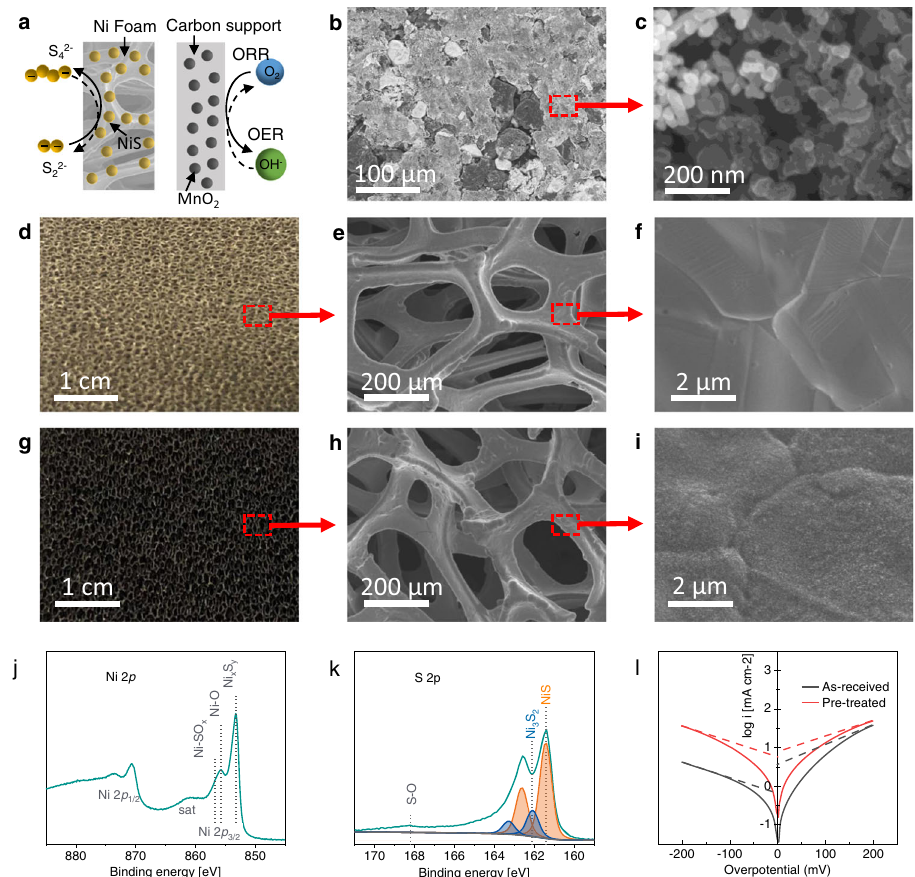
Fig. 2 Characterisation of electrodes. a Diagram of sul fi dized Ni foam electrode and MnO 2 -based air electrode for OER and ORR reactions. b , c SEM images of the commercial MnO2-based air electrode. d Photo of the as-received Ni foam. e , f SEM images of the as-received Ni foam. g Photo of the sul fi dised Ni foam. h , i SEM images of the sul fi dised Ni foam. j , k XPS core level spectra of the sul fi dised Ni foam. l Polarisation measurements of the as- received and sul fi dised Ni